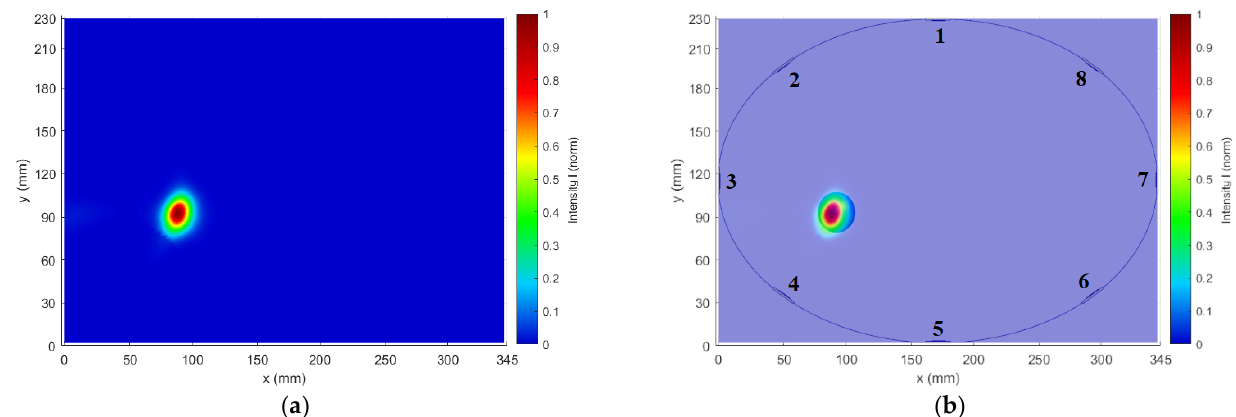
Figure 14. Hilbert envelope of differential signals calculated using 𝑆 𝑛𝑛 signals with the expected echo from the target.